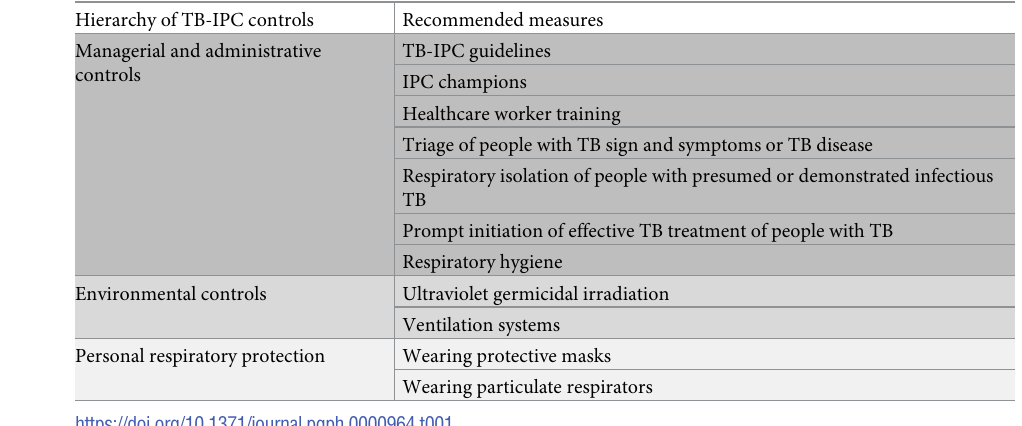
Table 1. Hierarchy of TB-IPC controls adopted from the WHO